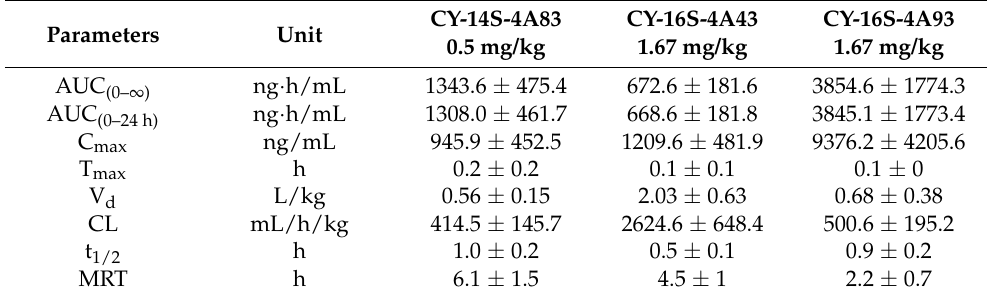
Figure 4. Arterial plasma concentration-time profiles of CY-14S-4A83, CY-16S-4A43, and CY-16S- 4A93 after intravenous administration to rats at a single dose of 0.5 mg/kg, 1.67 mg/kg, and 1.67 mg/kg, respectively. Table 4. PK parameters of CY-14S-4A83, CY-16S-4A43, and CY-16S-4A93 after intravenous adminis- tration to